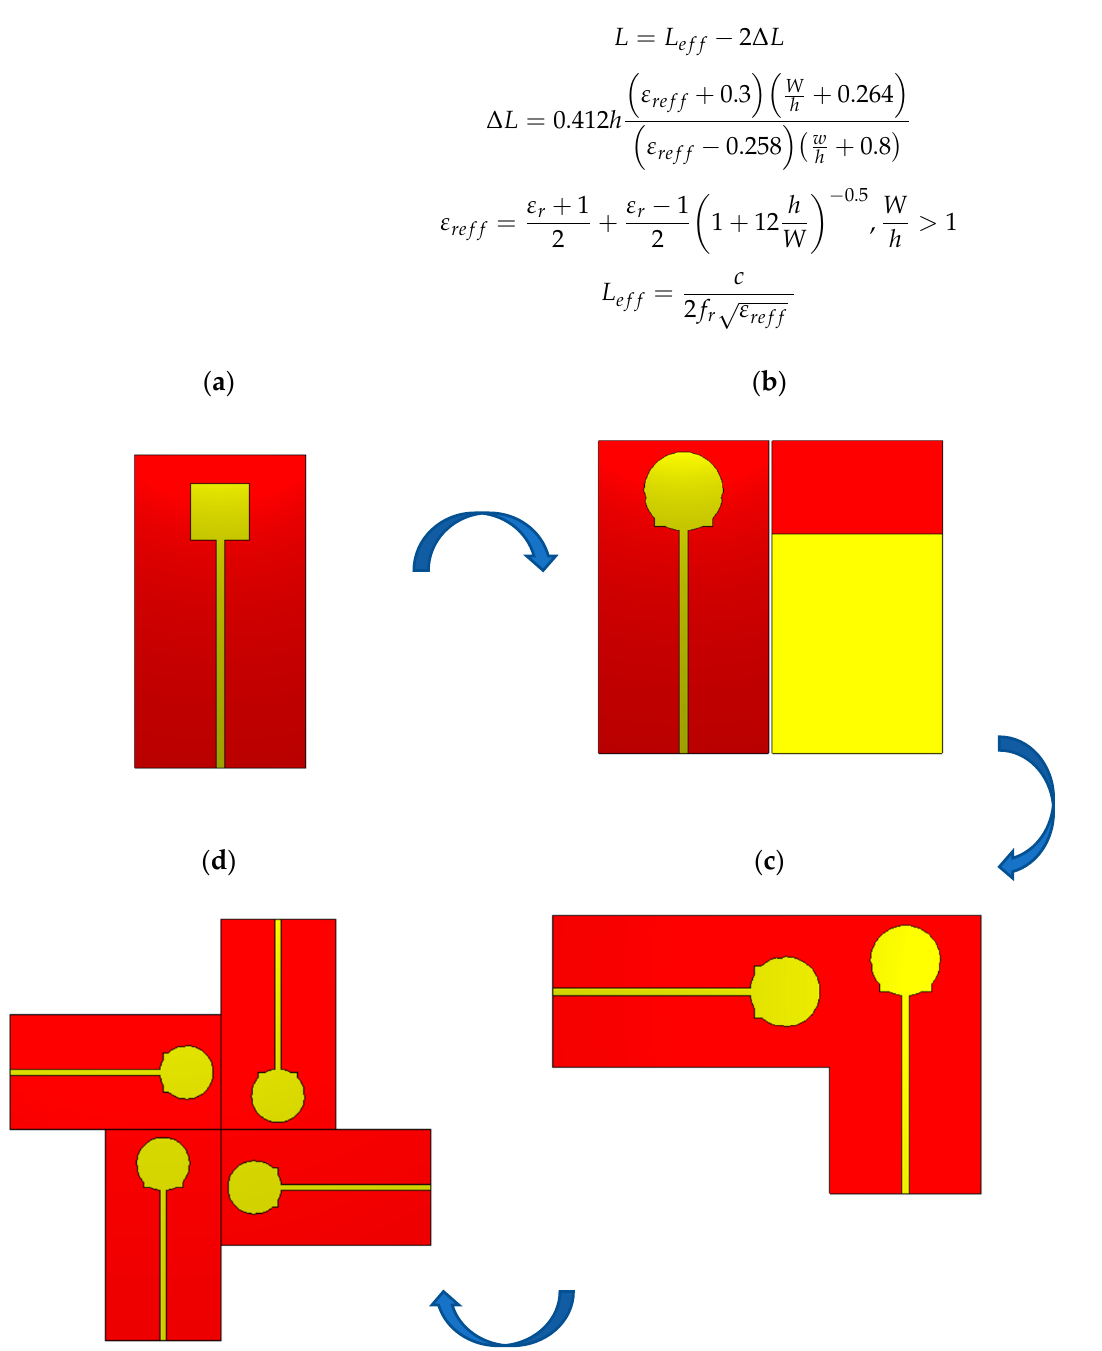
Figure 4. Steps of design ( a ) rectangular patch antenna with inset feed and full ground ( b ) single proposed antenna (top and bottom) ( c ) 2-port MIMO antenna with orthogonal orientation ( d ) Final step for 4-port MIMO